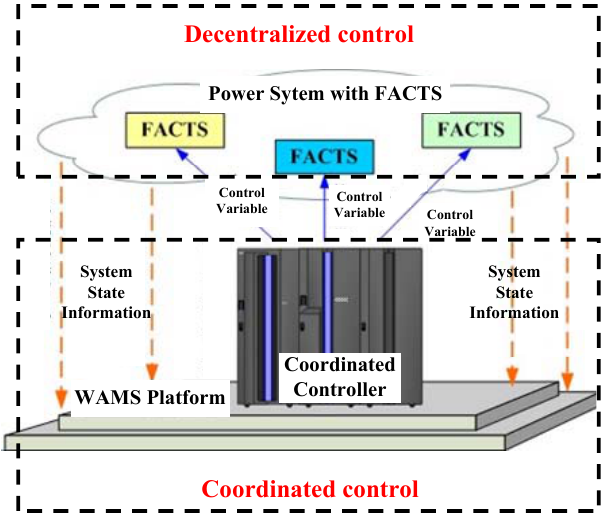
Figure 1. Coordinated control among FACTS devices based on WAMS.